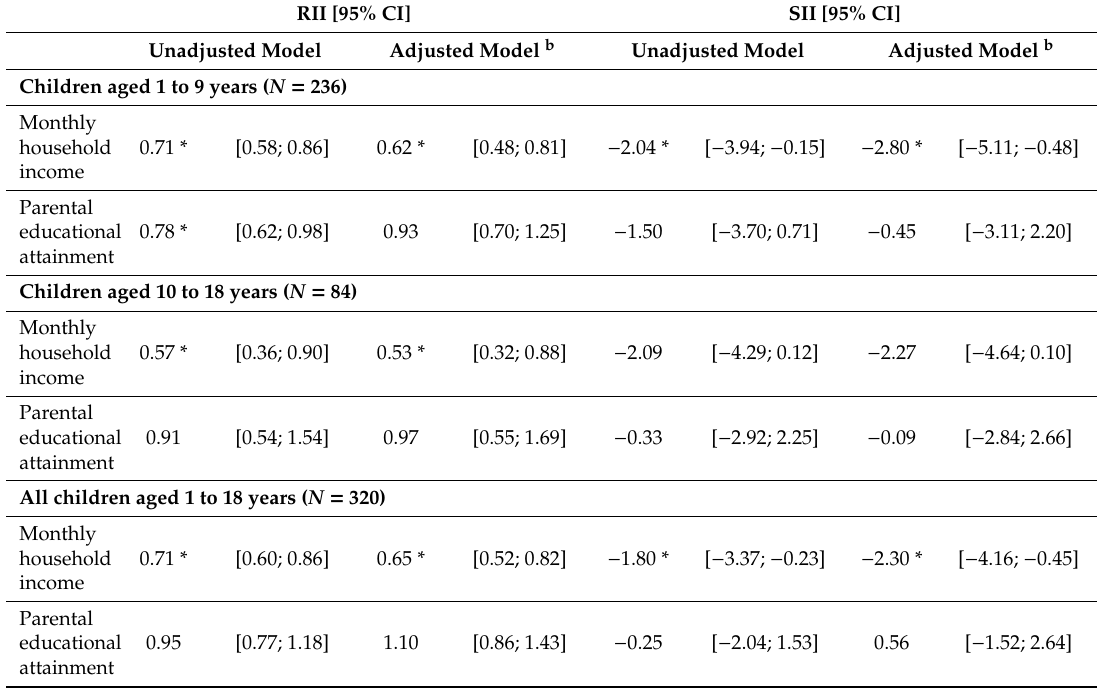
Table 2. Relative (relative index of inequality (RII)) and absolute (slope index of inequality